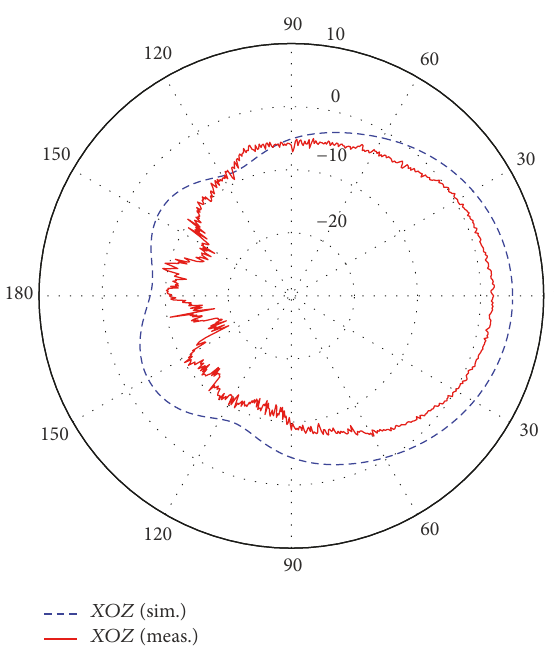
Figure 14: Radiation pattern of the antenna in XOZ plane at 5.725 GHz.